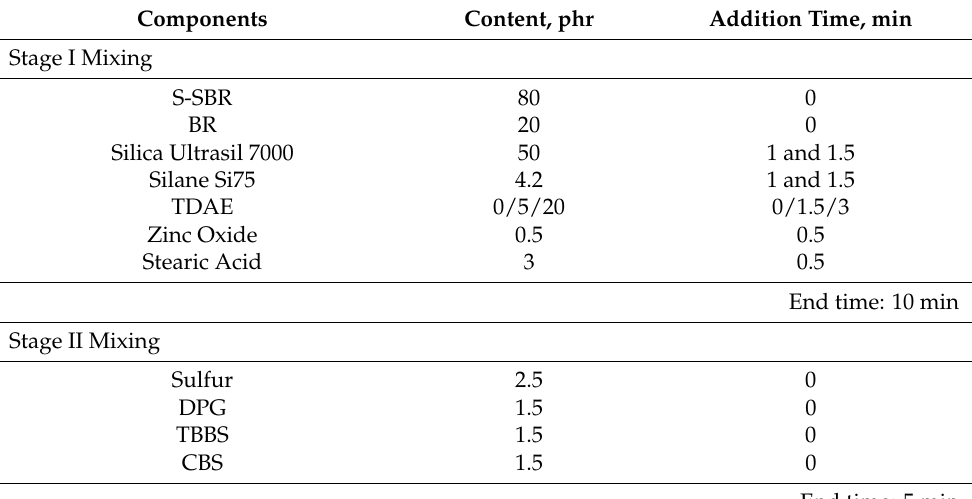
Table 1. Compound